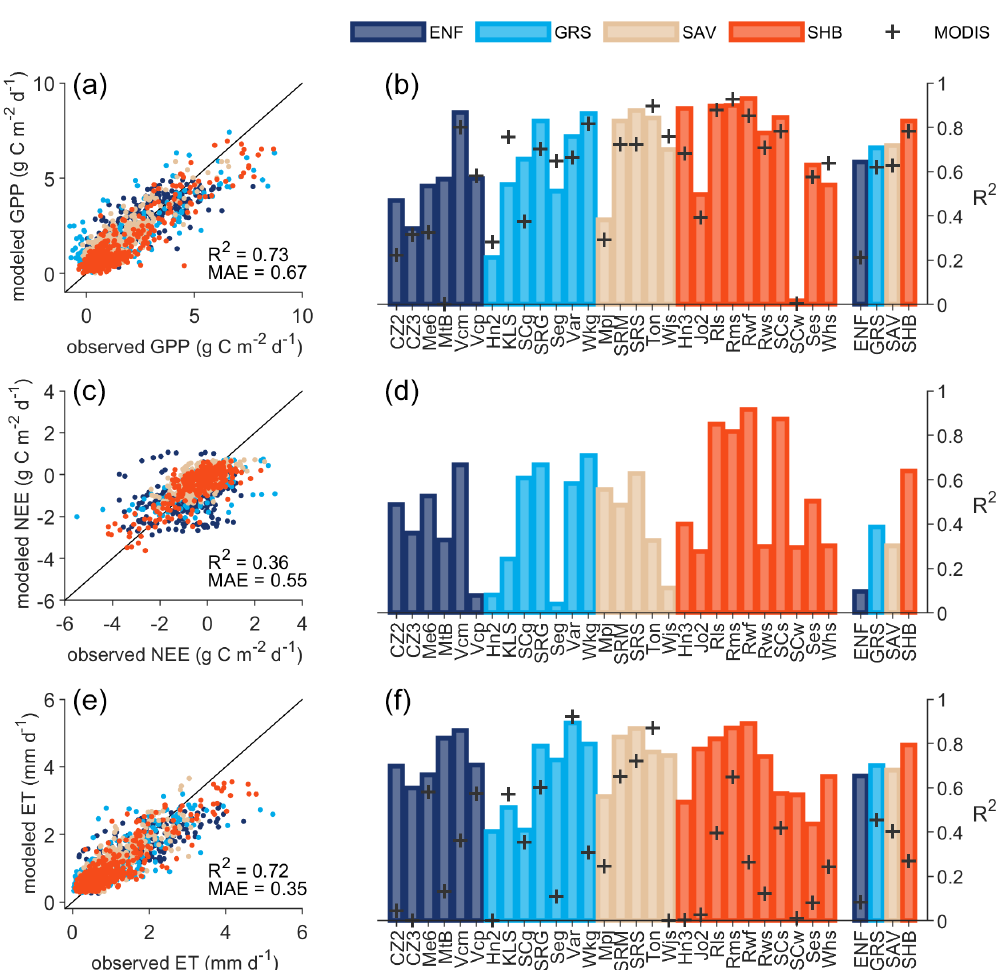
Figure 3. Overall performance of DrylANNd GPP (a,b) , NEE (c,d) , and ET (e,f) estimates at monthly timescale. Scatterplots show com- parison of monthly tower observations to cross-validated model estimates aggregated across all 28 eddy covariance sites (Table S1). Bar plots show the R 2 between monthly tower observations and cross-validated model estimates for each site individually and aggregated by vegetation type (Fig. 1). Gray “ + ” signs ( b and f ) show the MODIS product skill for each site and vegetation